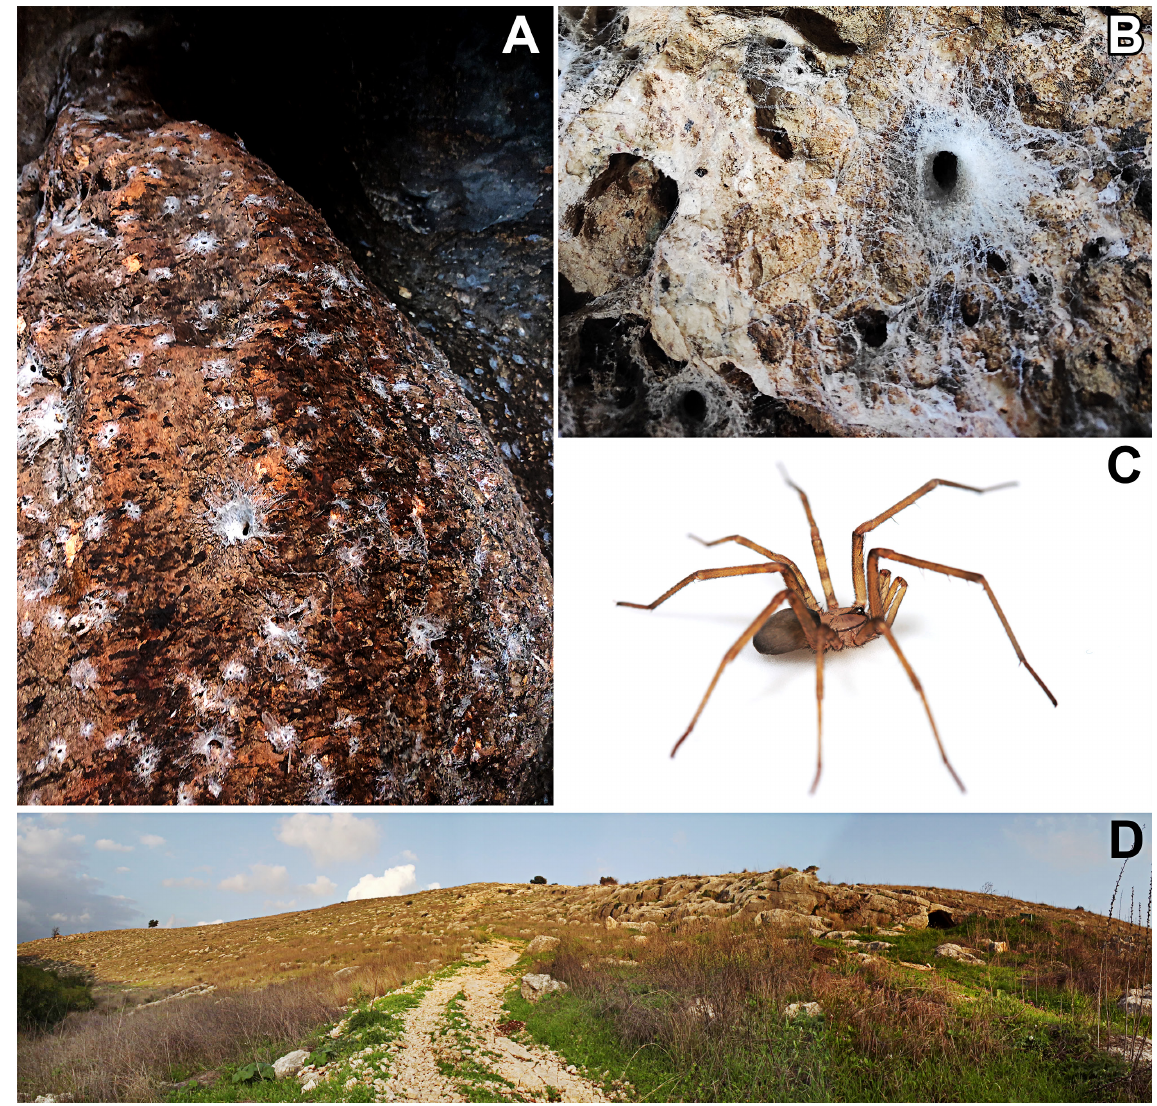
Fig. 1. A–B . Habitat and webs of Filistata betarif sp. nov. in Tinshemet cave. C . Paratype male in life (MACN-Ar 41793). D . Surroundings of Tinshemet cave. Note the entrance to the cave at the right side of the picture. Photos A–B by Shlomi Aharon and C–D by Ivan L.F.